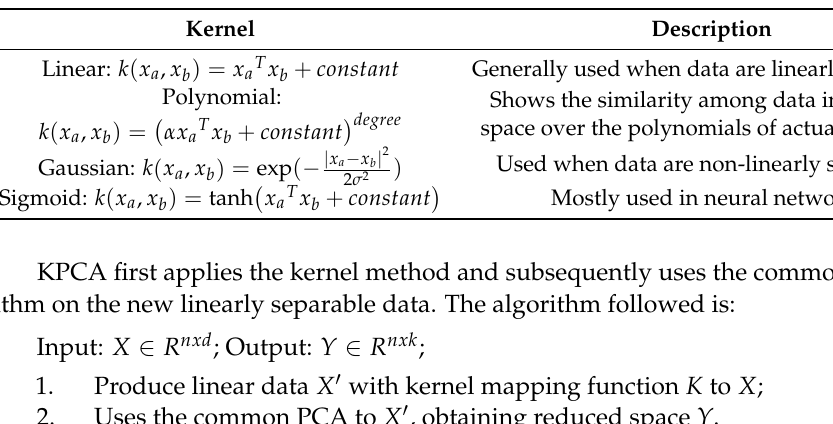
Table 5. Commonly used kernels in